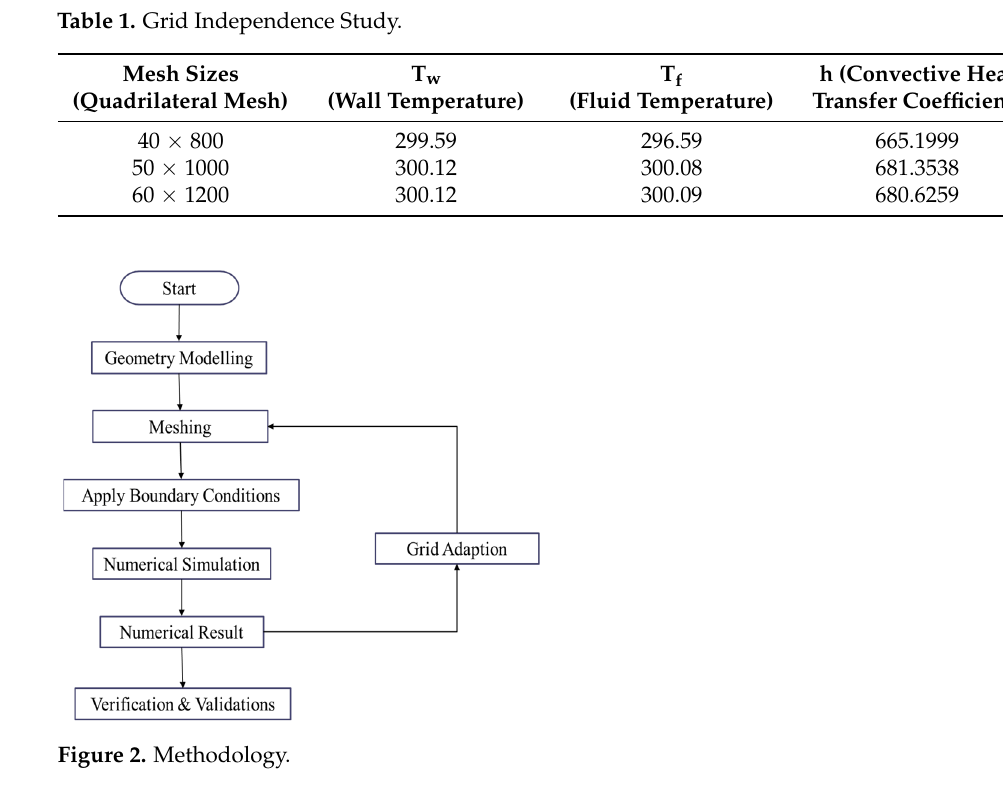
Figure 2. Methodology.